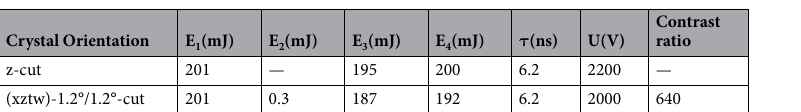
Crystal Orientation